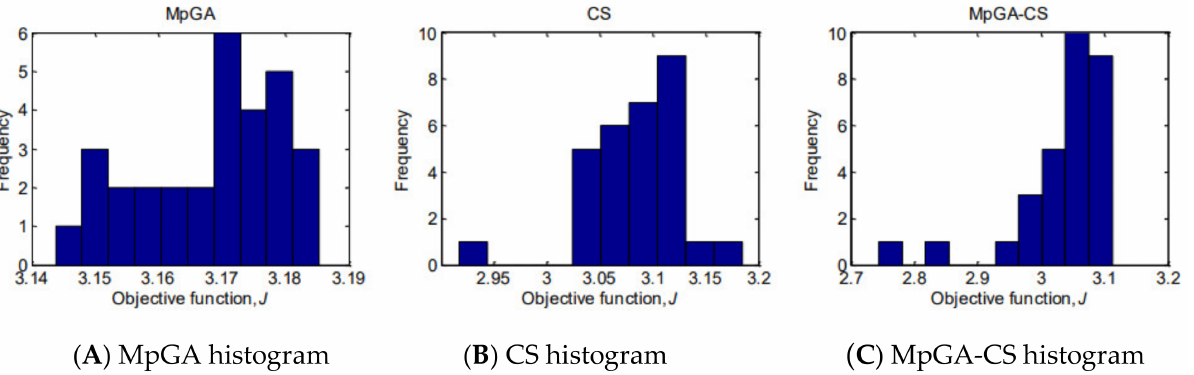
Figure 5. Histograms of the results for the objective function values from parameter identification of E. coli FP model (30